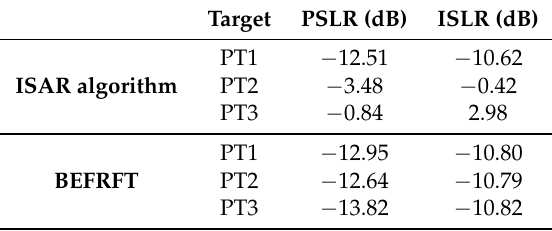
Table 2. Imaging quality parameters of PT 1, PT 2 and PT